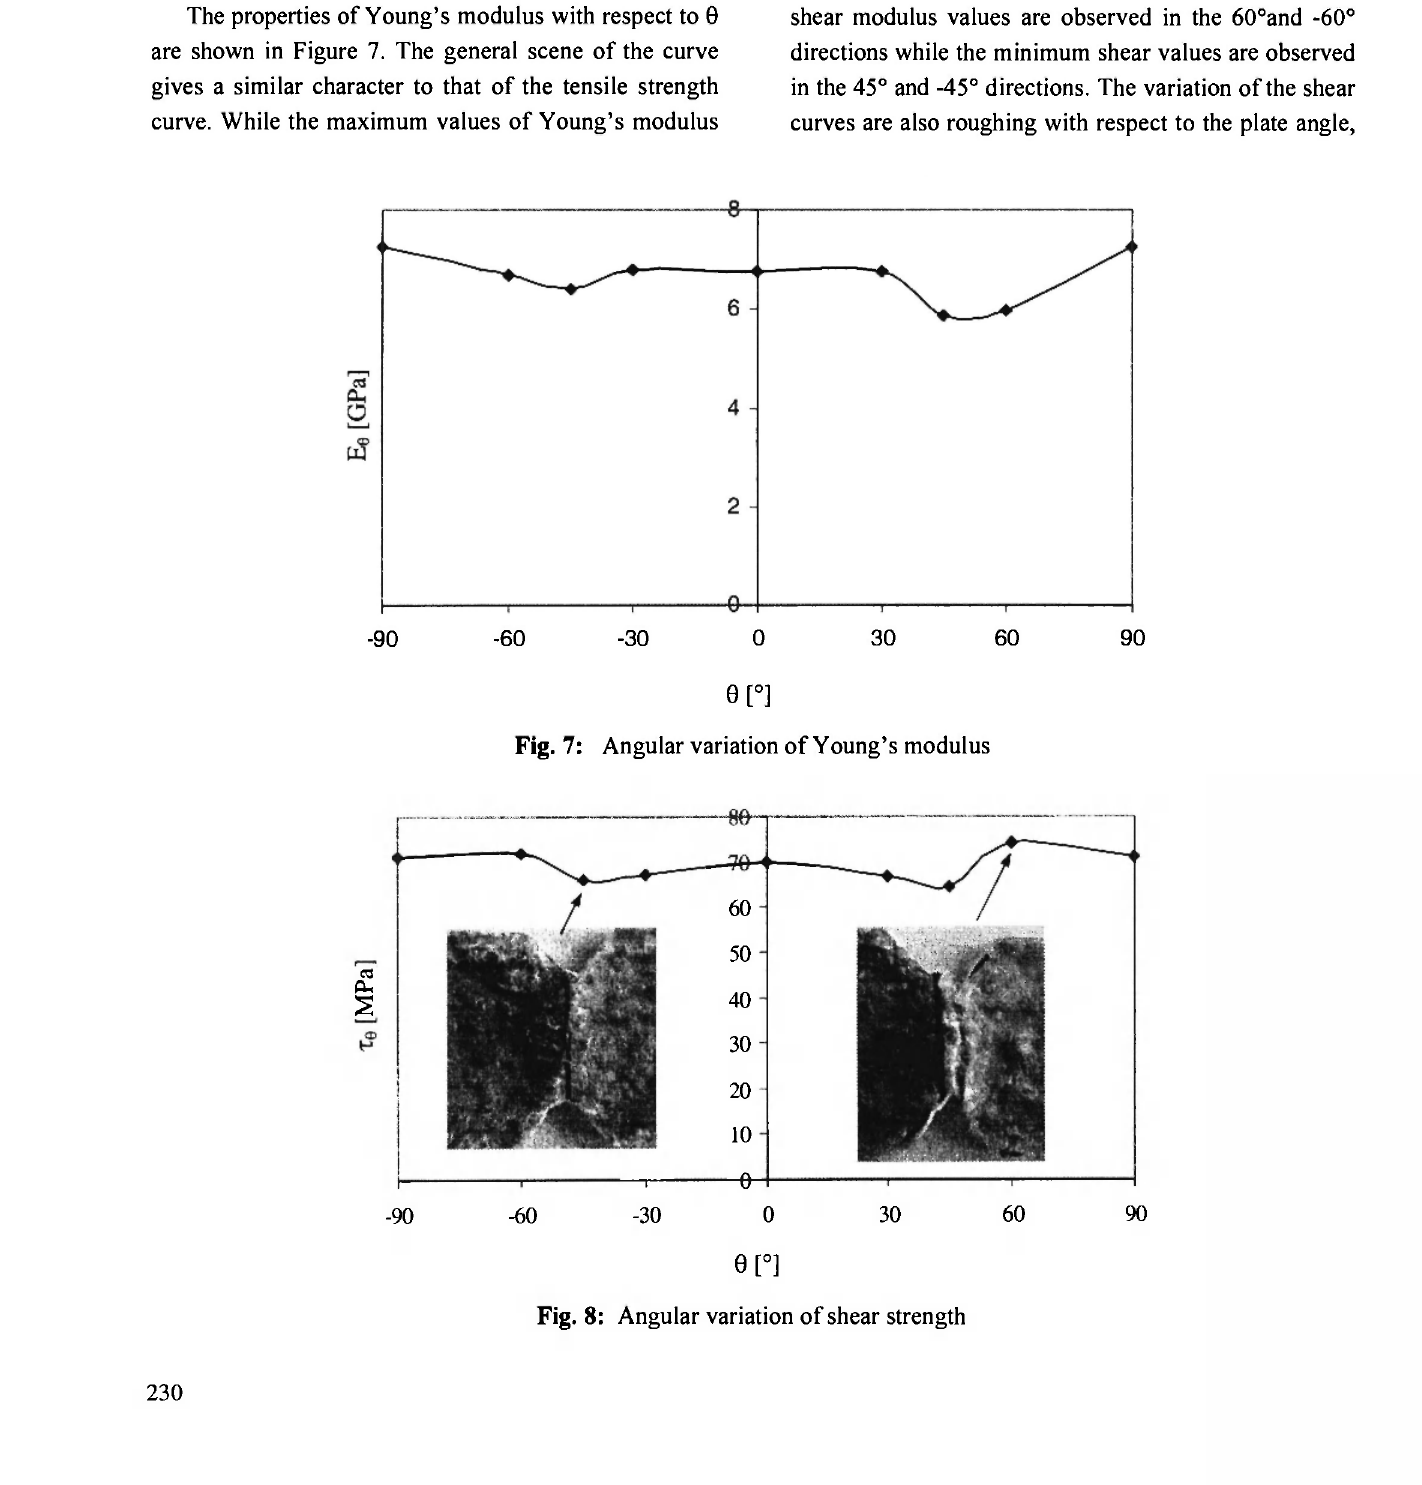
Fig. 8: Angular variation of shear